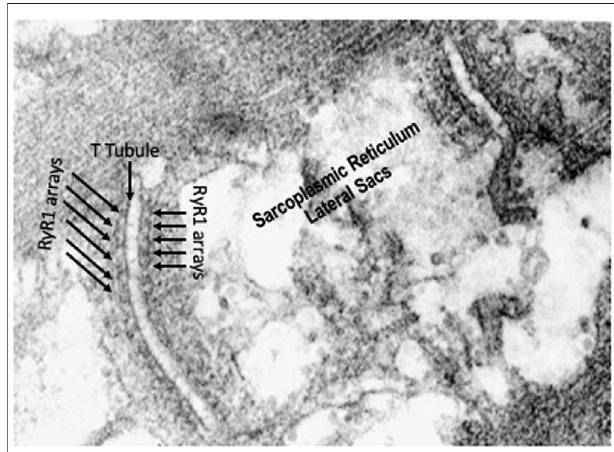
FIGURE 4 | High resolution electron micrograph showing the triads made upoft-tubules/lateralsacs ofthesarcoplasmic reticulumand ryanodine receptor arrays on both sides of the t-tubule.